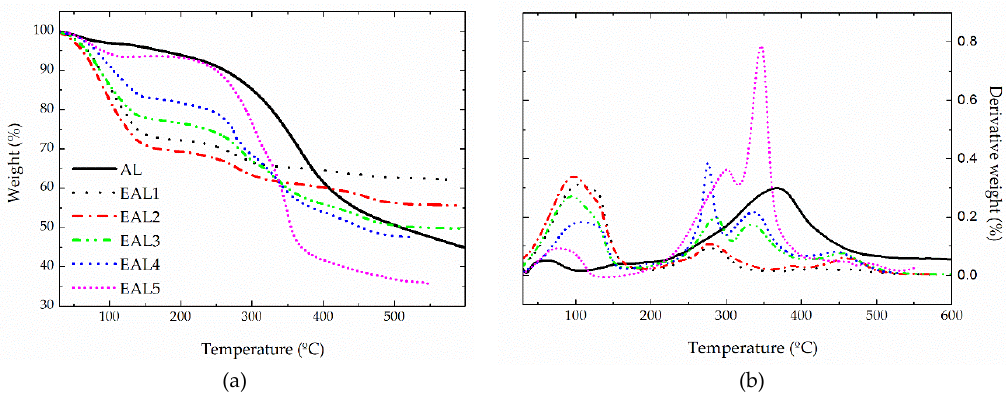
Figure 2. Loss weight ( a ) and decomposition-rates ( b )curves during the thermal degradation for the original alkali lignin and epoxidized lignin samples.